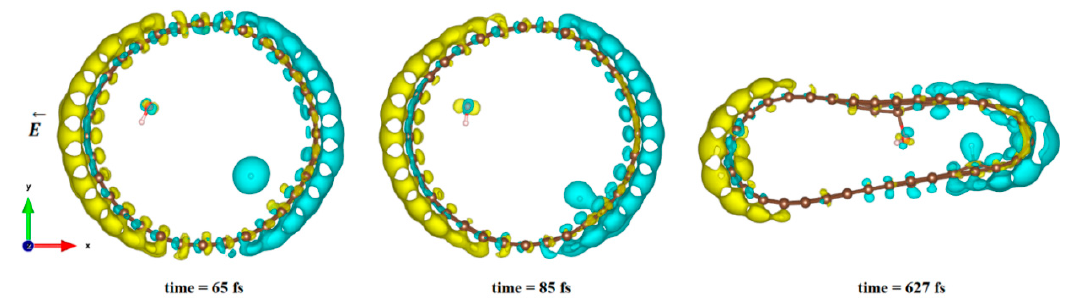
Figure 4. Difference in charge density distribution of the dissociated water molecule inside the CNT under 25 eV electric field. The yellow and blue lobes represent the positively and negatively charged areas, respectively.